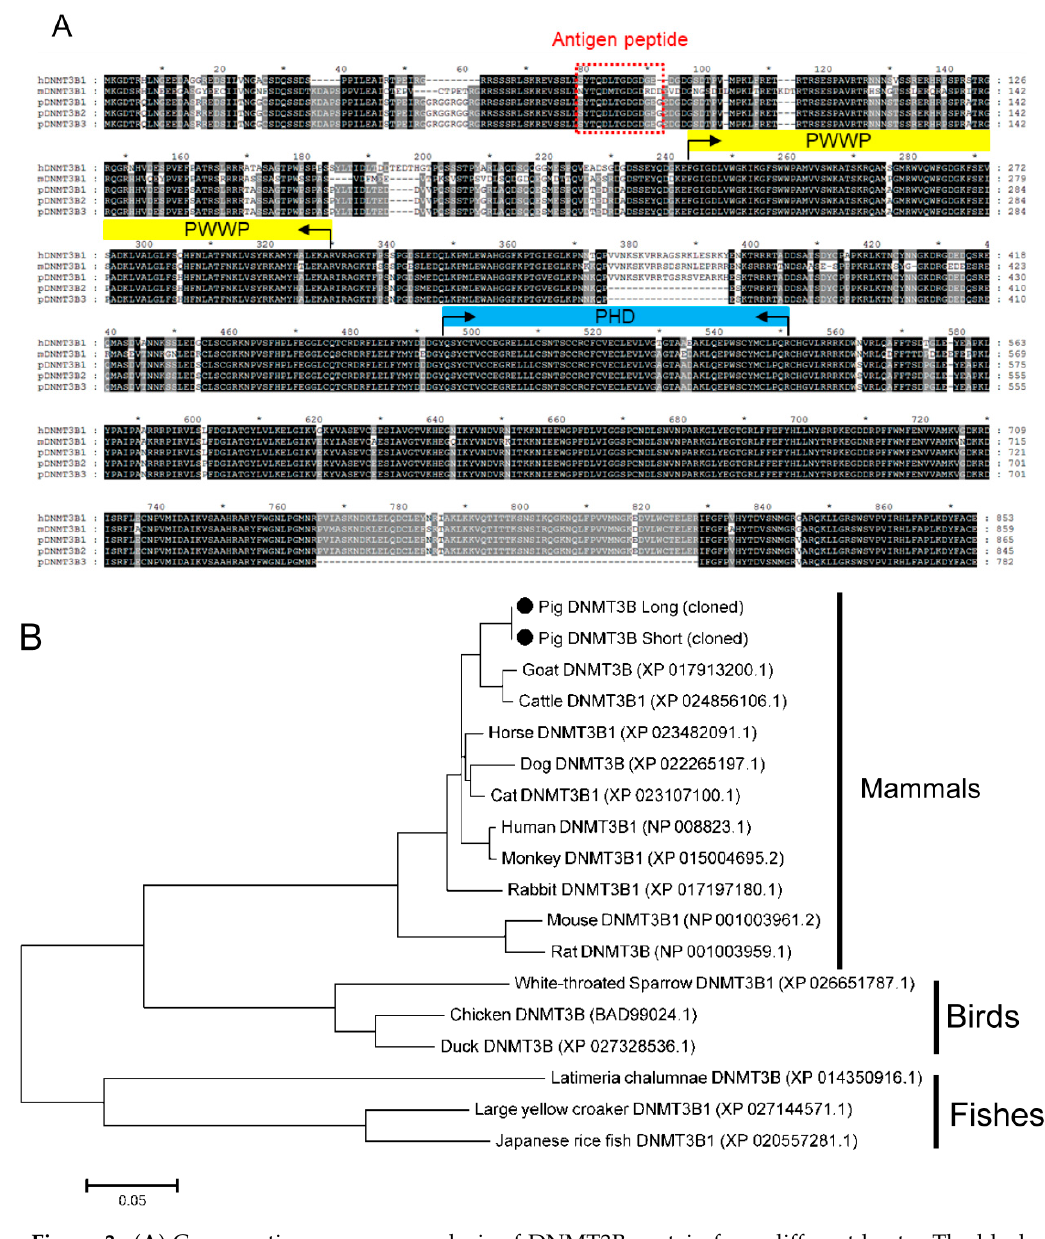
Figure 3. ( A ) Comparative sequence analysis of DNMT3B protein from di ff erent hosts. The black and gray shading highlight identity in all of the selected sequences and similarity, respectively. The PWWP (yellow line) and PHD (blue line) domains are labeled in reference to the human DNMT3B1 (NP_008823.1), respectively. Moreover, the antigen peptide is shown in the red box. ( B ) Phylogeny analysis of DNMT3B protein from di ff erent hosts. The scale bar indicates the genetic distance.